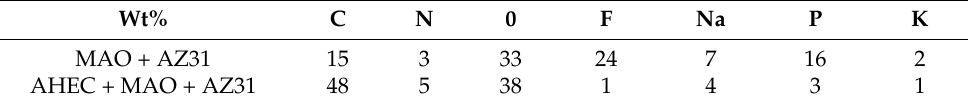
Figure 5. Energy-dispersive X-ray spectroscopy (EDS) determination of elemental distributions in ( a ) MAO + AZ31 and ( b ) AHEC + MAO + AZ31. Table 2. EDS of samples (Round numbers).